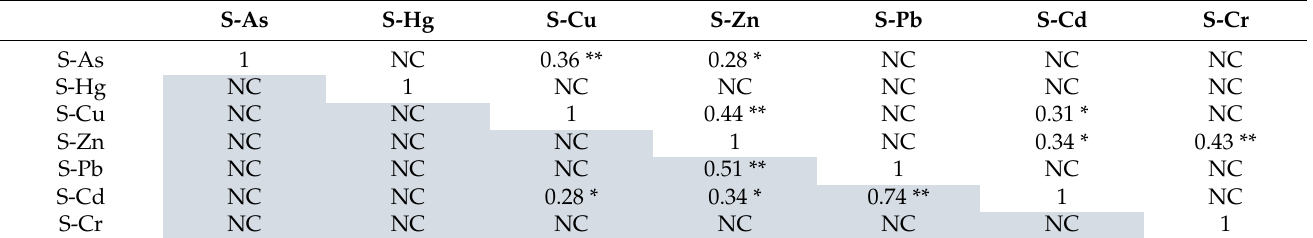
Table 4. Correlation analysis of coexistence of PTEs in farmland